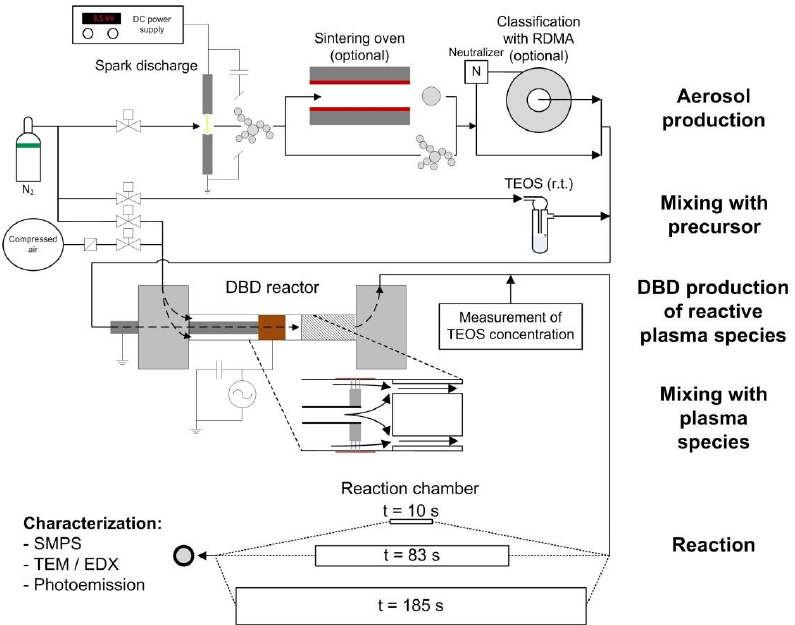
Figure 1. Experimental setup with the different process